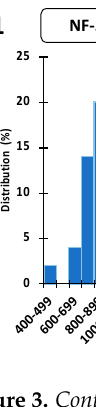
Figure 3. SEM images and diameter distributions of nanofibrous samples produced by nozzle-free electrospinning. The scale bar is 10 µm on every microscopic image. ( A1 ) In the case of the nano- fibers containing 5 w% ciprofloxacin (NF-5), the free-surface electrospinning was successful. The average fiber diameter was 1167 ± 415 nm, but the size distribution was polydisperse and strongly skewed left. ( A2 , A3 ) The fibers were mainly individual and had smooth surfaces. ( B2 , B3 ) The noz- zle-free electrospinning of 10 w% ciprofloxacin containing nanofibers (NF-10) was impractical; in- stead of separated fibers, merged fiber balls and polymer films were prepared. ( B1 ) Thus, the fiber size was not measurable and the distribution was not interpretable. 3.3. Structural Characterization It is known that during the ES process the crystal structure of the active substance may change, in most cases amorphizing. The amorphizing effects of ES has been con- firmed in several previous studies [29,44,49,54,55,60,62]. Therefore, nanofibers can be con- sidered as amorphous solid dispersions. Two types of experiments, DSC and XRPD, were performed to prove that both ES methods could produce amorphous solid dispersions. Figure 4A presents the DSC thermograms of CIP powder, physical mixtures (PM-5 and PM-10), and samples made by nozzle-based ES (SN-5 and SN-10) and nozzle-free ES (NF-5). The sharp endothermic peak at 275 °C for CIP powder and physical mixtures rep- resents the melting point of crystalline CIP. As the size of the peak depends on the amount of the crystalline material, the peak of the 5% CIP-loaded sample (PM-5) was approxi- mately half the intensity of the peak of the 10% CIP-containing sample (PM-10). However, the peak did not appear in the thermograms of nanofibers because of the absence of a